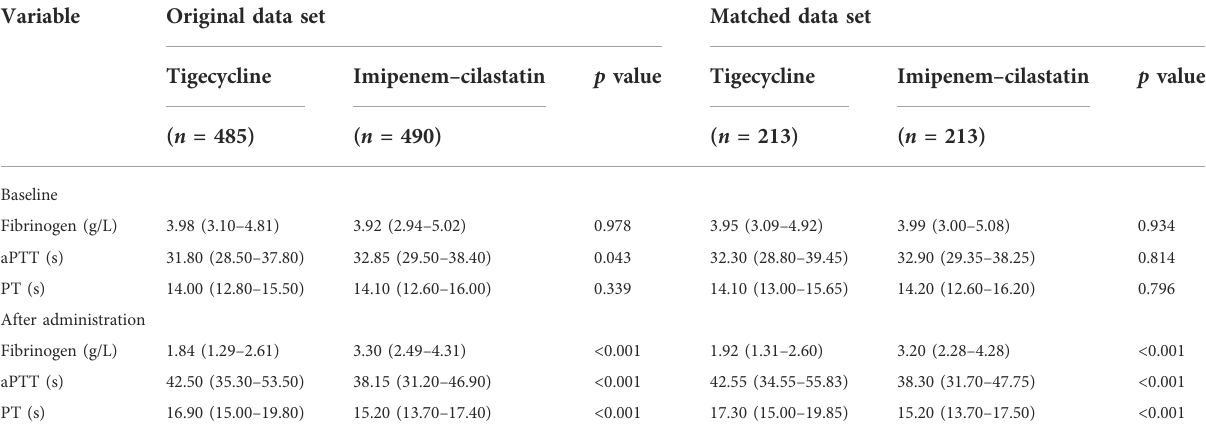
TABLE 2 Comparison of coagulation tests between tigecycline and imipenem – cilastatin groups in the original and matched data